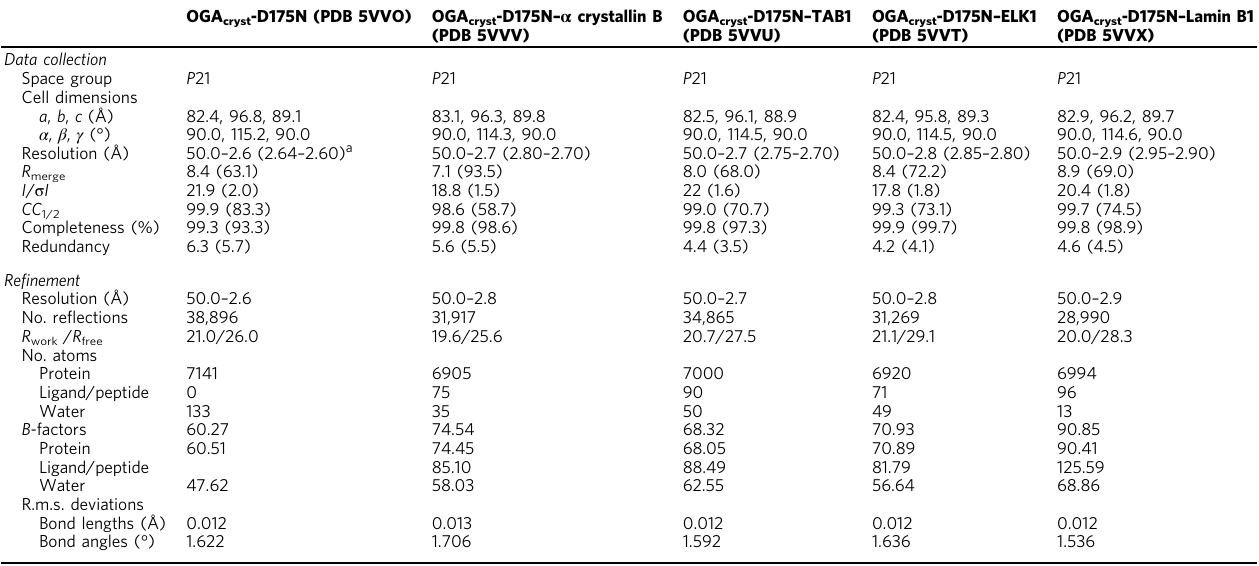
Table 1 Data collection and re fi nement statistics (molecular replacement)